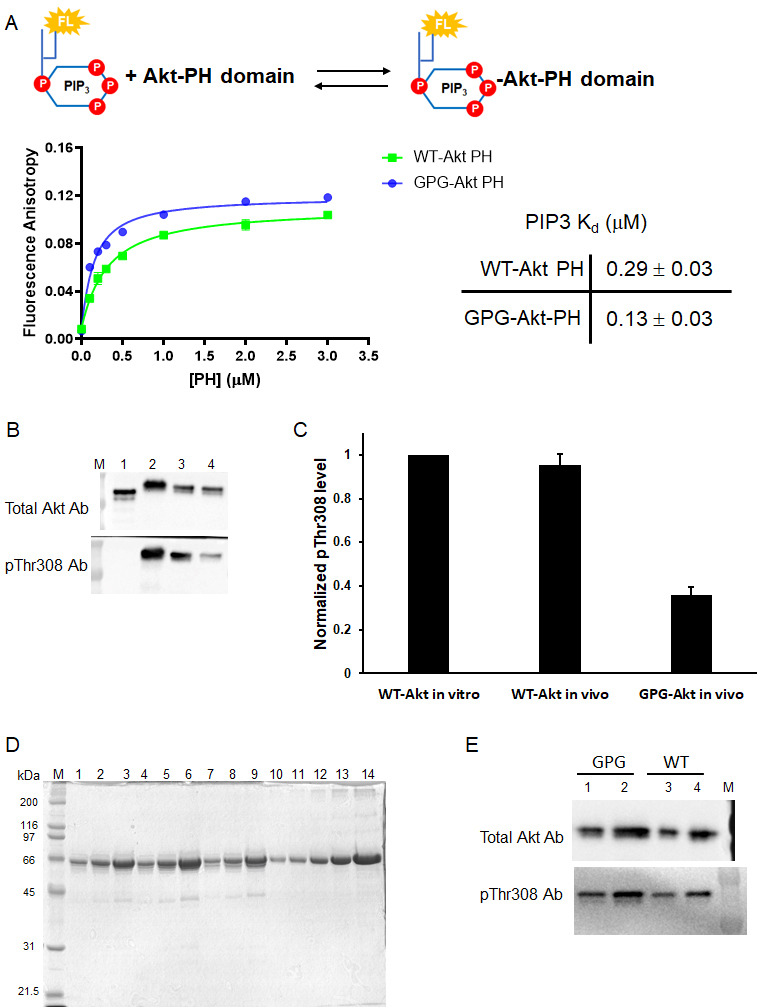
A short hinge 44-46 aa affects Thr308 phosphorylation but not PIP2 affinity.(A) Fluorescence anisotropy measurements of Akt PH domains WT and GPG mutant with fluorescein-labeled soluble PIP3 (n = 2). The obtained PIP3 Kd values expressed in the table (right) with S.D. shown. (B) Western blot analysis of pThr308 level for WT and GPG-Akt with pThr308 obtained from Sf9 co-expressed Akt(aa 1–459)-MxeIntein-CBD and GST-PDK1, and treated with okadaic acid (in vivo pThr308). Lane 1: truncated Akt(aa 2–459) without pThr308, lane 2: full-length WT Akt following in vitro PDK1-catalyzed pThr308 (WT-Akt in vitro), lane 3: full-length WT Akt pThr308 obtained with PDK1 co-expression and okadaic acid treatment (WT-Akt in vivo), lane 4: full-length GPG Akt mutant with in vivo pThr308 (GPG-Akt in vivo). (C) Quantification of western blot intensities in (B). (D) Semisynthesis of pThr308 GPG-Akt proteins with pSer473 (lanes 1–3), dual-pSer477/pThr479 (lanes 4–6) and non-p C-tail (lanes 7–9), lanes 10–14: BSA standards. Regarding to partial GPG-Akt Thr308 phosphorylation shown in (B) and (C), truncated GPG-Akt(aa 1–459) thioester fragment was further treated with PDK1 in in vitro kinase reaction to reach similar pThr308 level for WT-Akt. (E) Western blot analysis of pThr308 level for GPG (lanes 1–2, obtained from D) and WT (lanes 3–4) Akt proteins with pSer473 with different loading amounts 25 ng (lanes 1, 3) and 50 ng (lanes 2, 4).